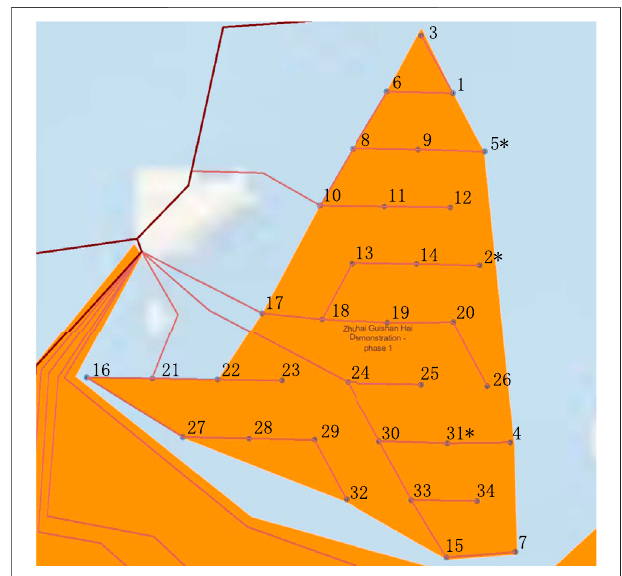
FIGURE 2 | Distribution map of Guishan offshore wind farm in